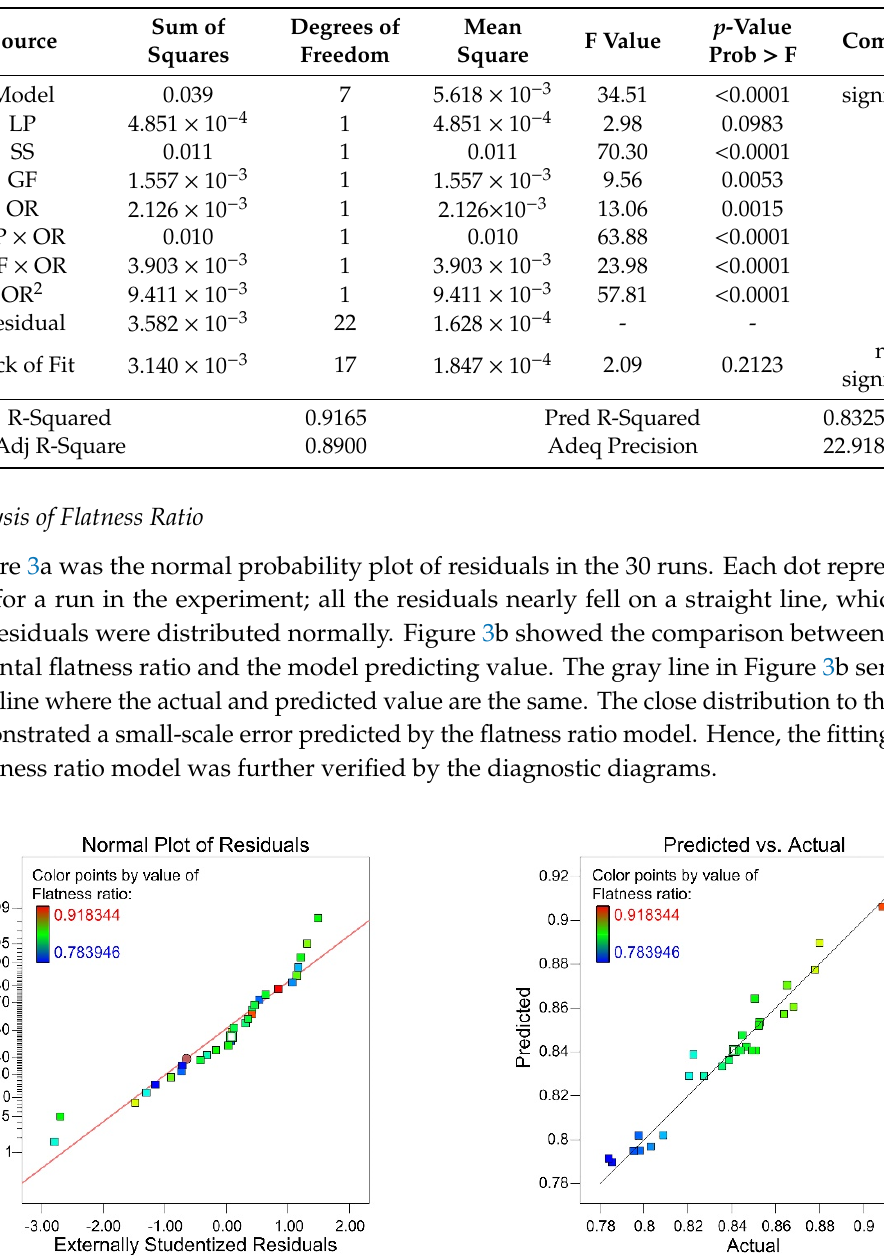
Table 7. Analysis of variance on pore area.